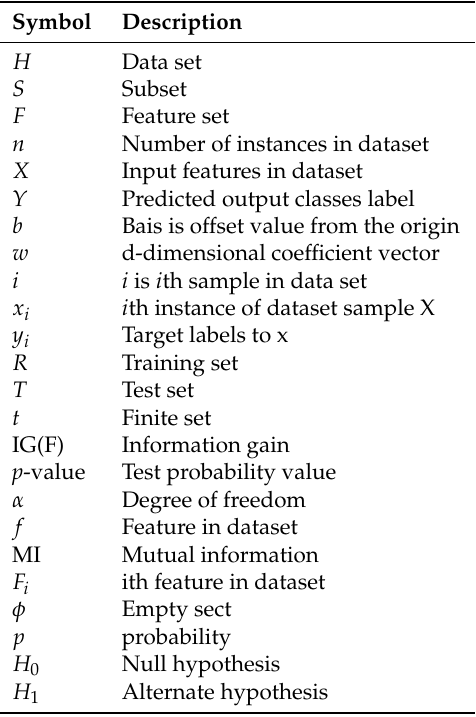
Table 1. Mathematically symbols and notations Used in the